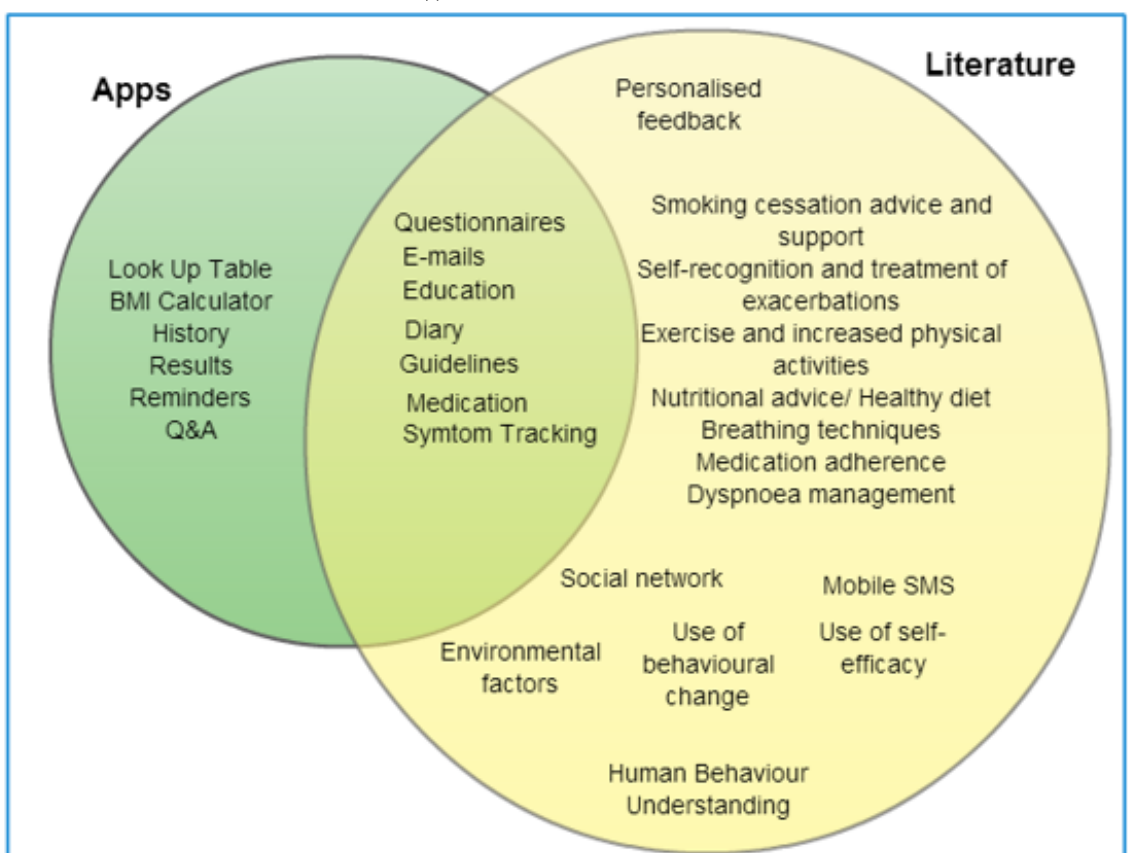
Figure 4. Common features identified in the downladed apps and in the